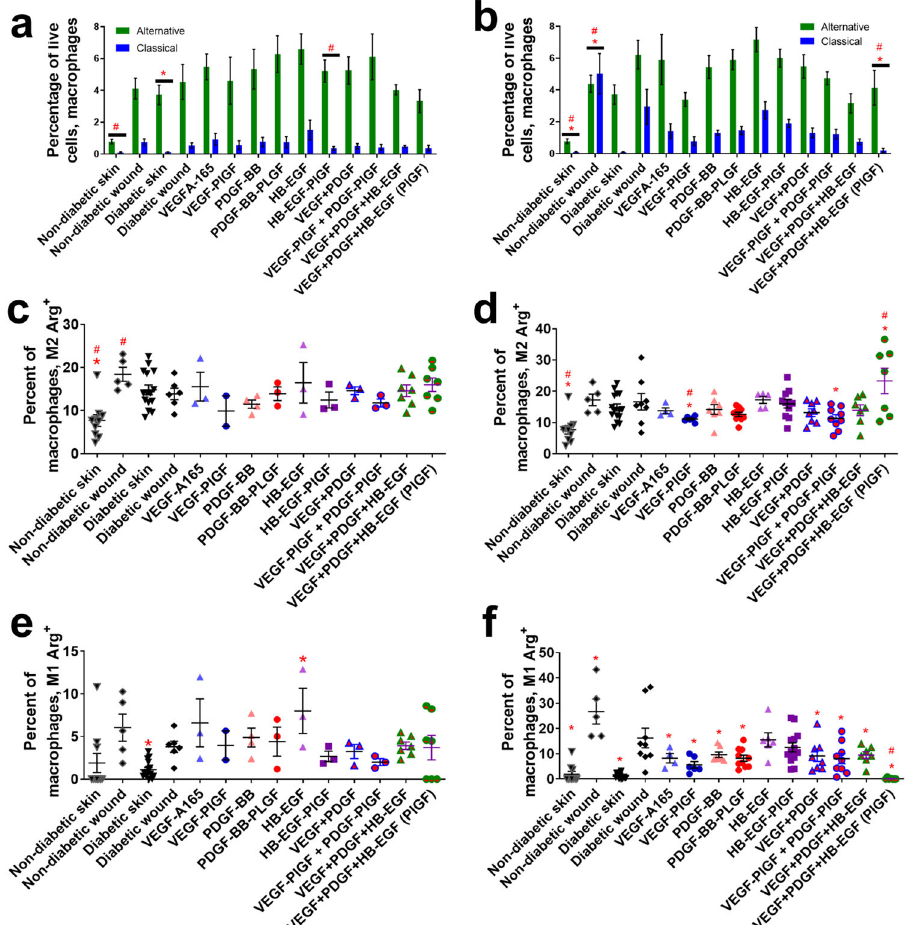
Fig. 4 Macrophage cell count in wounds after 3 – 7 days of healing. In fl ammatory M1 (CD45 + , CD11b + , CD11c − , Ly6G − , Ly6C low , SSC high , MHC class II + ) vs alternatively activated M2 (CD45 + , CD11b + , CD11c − , Ly6G − , Ly6C high , SSC low , CD206 + ) macrophages after ( a ) 3 days or ( b ) 7 days. Arginase + alternatively activated macrophages after ( c ) 3 days or ( d ) 7 days. Arginase + classically activated macrophages after ( e ) 3 days or ( f ) 7 days. Comparison includes unwounded skin from both the NOD and NOR mice. n ranges from 3 to 20. * Denotes comparison to the diabetic wound. # Denotes a comparison between untreated NOD wound and untreated NOR wound, and the WT GF(s) are compared to their counterpart -PlGF-2 123 – 144 variant(s), e.g., VEGF vs VEGF- PlGF-2 123 – 144 . * p < 0.05, p < 0.01, p < 0.001, Kruskal-Wallis + Mann-Whitney post hoc test. # p < 0.05, p < 0.01, p < 0.001, Mann-Whitney. Error bars are